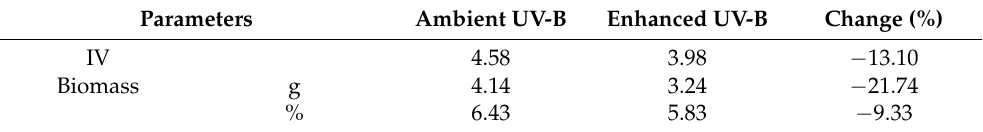
Table 2. Effects of enhanced UV-B on the Importance Value and biomass of K. humilis .